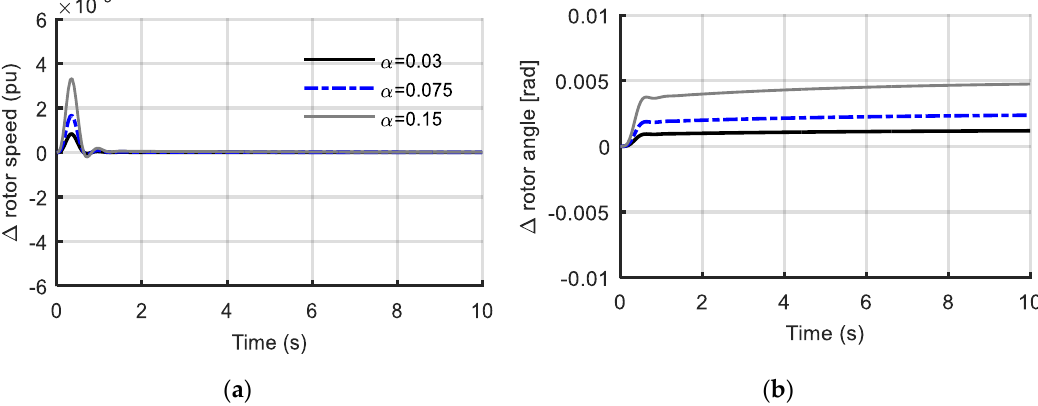
Figure 7. SG performance with considering wind power impact at P = 1 pu, Q = 0.25 pu. ( a ) Rotor speed deviation; ( b ) rotor angle deviation.